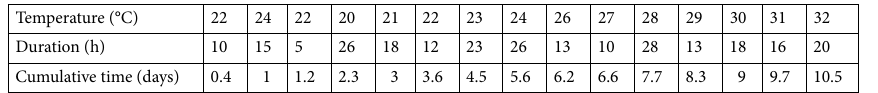
Table 3. Evaluation of temperature under the variable-temperature curing